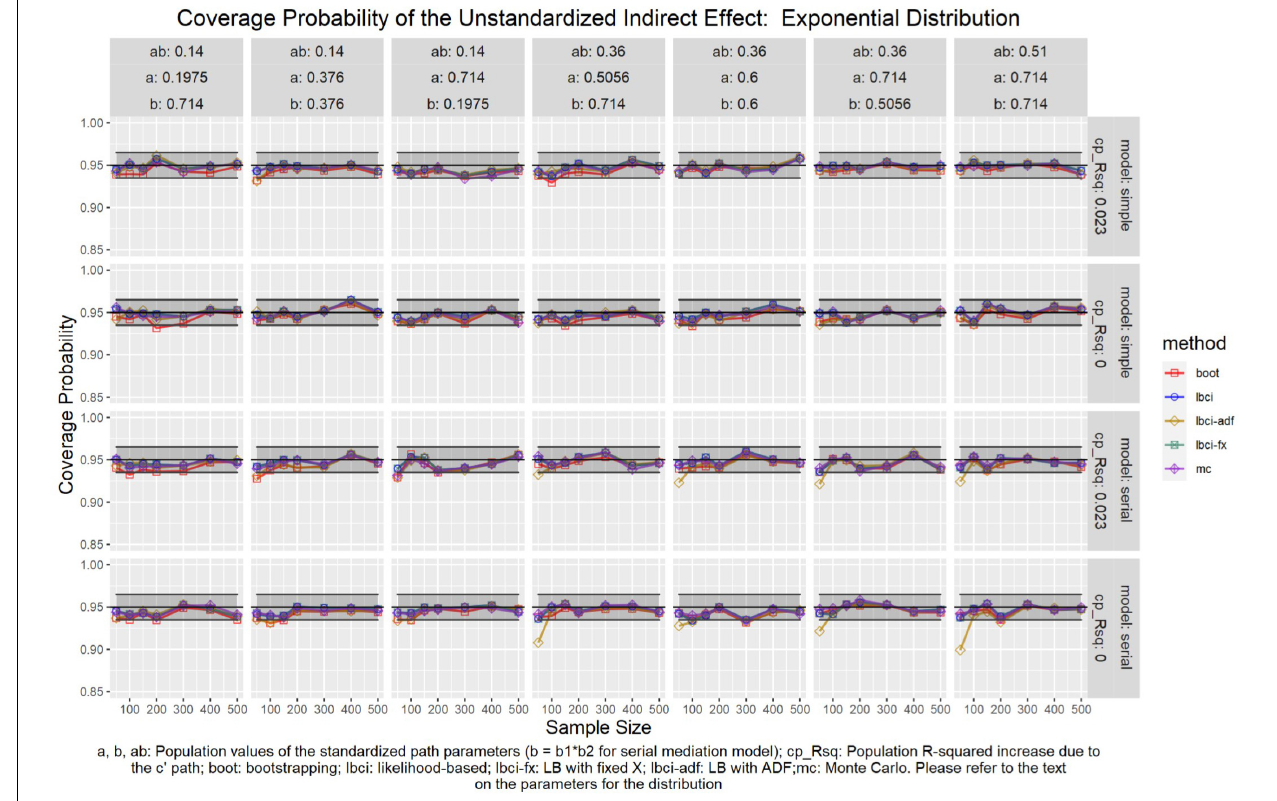
FIGURE 8 | Exponential Distribution (Unstandardized Indirect Effect). a, b, ab: Population values of the standardized path parameters (b = b1 × b2 for serial mediation model); cp_Rsq: Population R-squared increase due to the c (cid:48) path; boot: bootstrapping; Ibci: likelihood-based; Ibci-fx: LB with fixed X; Ibci-adf: LB with ADF;mc: Monte Carlo. Please refer to the text on the parameters for the